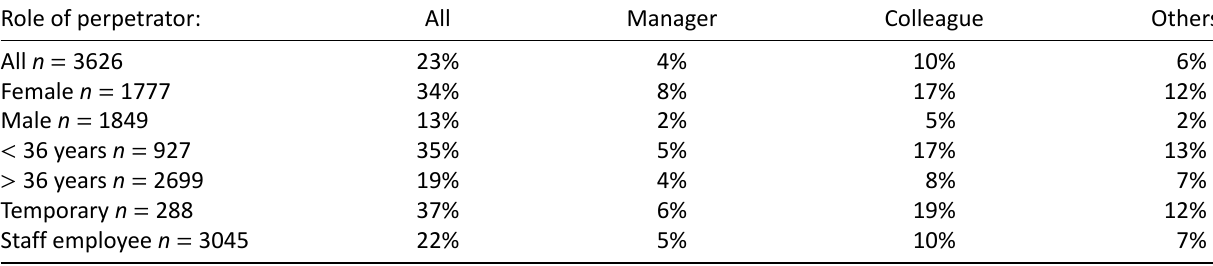
Table 4. Frequency of UA in last six months (score on at least one item). Role of